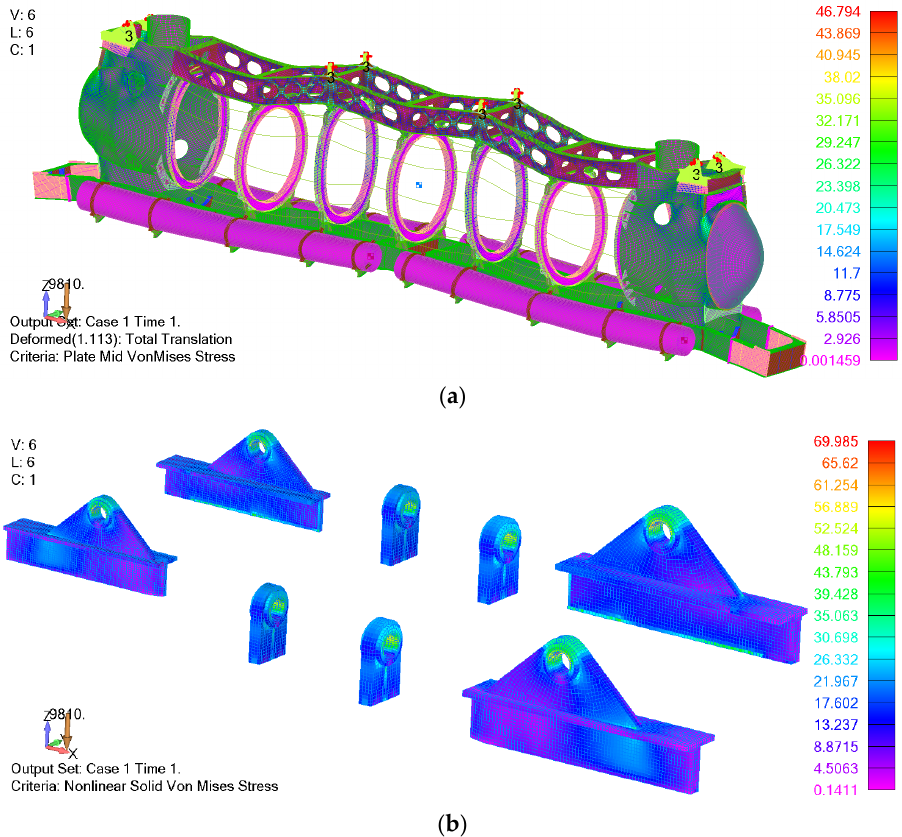
Figure 14. The von Mises stresses in MPa of the vessel for the lifting condition; ( a ) plate elements, ( b ) solid elements. ( b ) solid